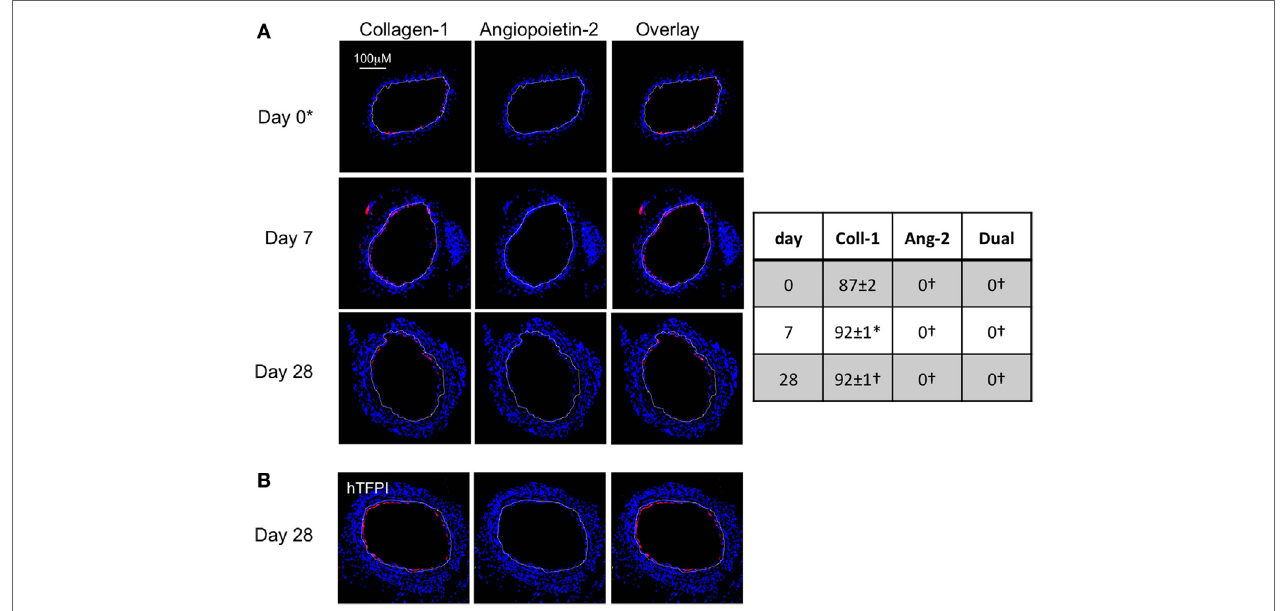
FigUre 3 | Adoptive transfer of CD31-TFPI-Tg CD34 + cells to wild-type (WT) mice immediately post-injury. Panels show immunohistology of representative sections through injured mouse carotid arteries harvested on days post-injury as indicated. All sections stained with DAPI (4,6 diamidino-2-phenylindole) nuclear stain (blue) and (red) anti-collagen-1 (a) or human tissue factor pathway inhibitor (B) and (green) anti-angiopoietin-2. Yellow indicates co-localization. The annotated white line defines the junction between neointima and media. *On day 0, sections harvested within an hour of injury. Table besides panel (a) describes summary of staining from all mice ( n = 6), showing the proportion of the neointimal area that is positive for collagen-1, angiopoietin-2, or both on days 0, 7, and 28 (% ± SEM). Data derived from three random sections from each of the arteries from each mouse (see Materials and Methods). *cf WT cells (see Figure 1B ) at equivalent time point p = 0.03. † cf WT cells ( Figure 1B ) at equivalent time point p < 0.001. Experiments repeated at least